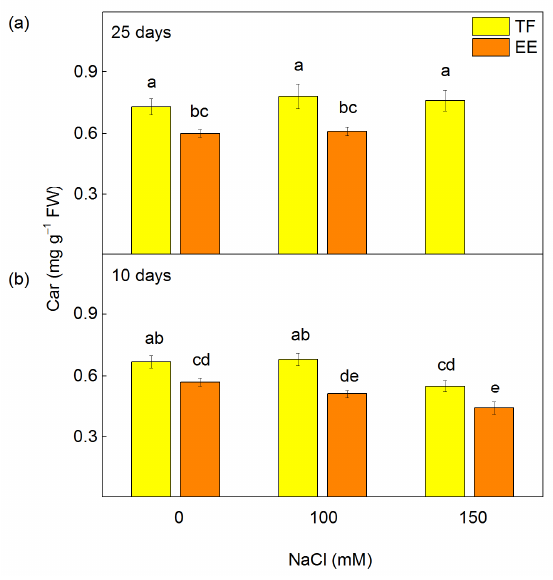
Figure 2. Effect of different concentrations of NaCl on the carotenoid content in leaves of Paulownia tomentosa x fortunei (TF) and Paulownia elongata x elongata (EE). The plants were treated for 10 ( b ) and 25 days ( a ). Mean values (±SE) with different letters have statistically significant differences at p < 0.05.